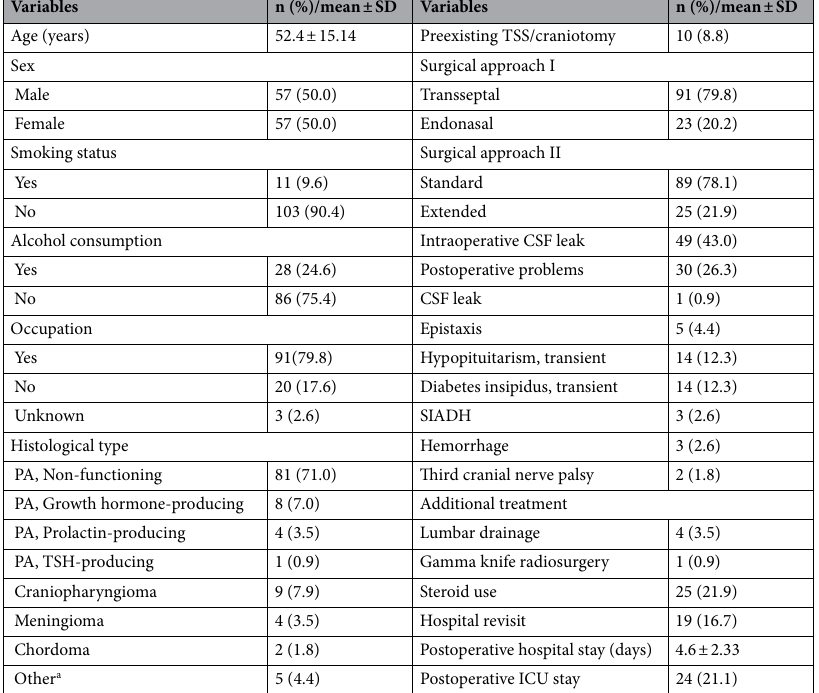
Table 1. General and clinical characteristics of patients (N = 114). CSF Cerebrospinal fluid, ICU intensive care unit, PA pituitary adenoma, SIADH syndrome of inappropriate secretion of antidiuretic hormone, TSS transsphenoidal surgery, TSH thyroid stimulating hormone. a Other: metastasis, arachnoid cyst, rathke cleft cyst, solitary fibrous tumor, and spindle cell